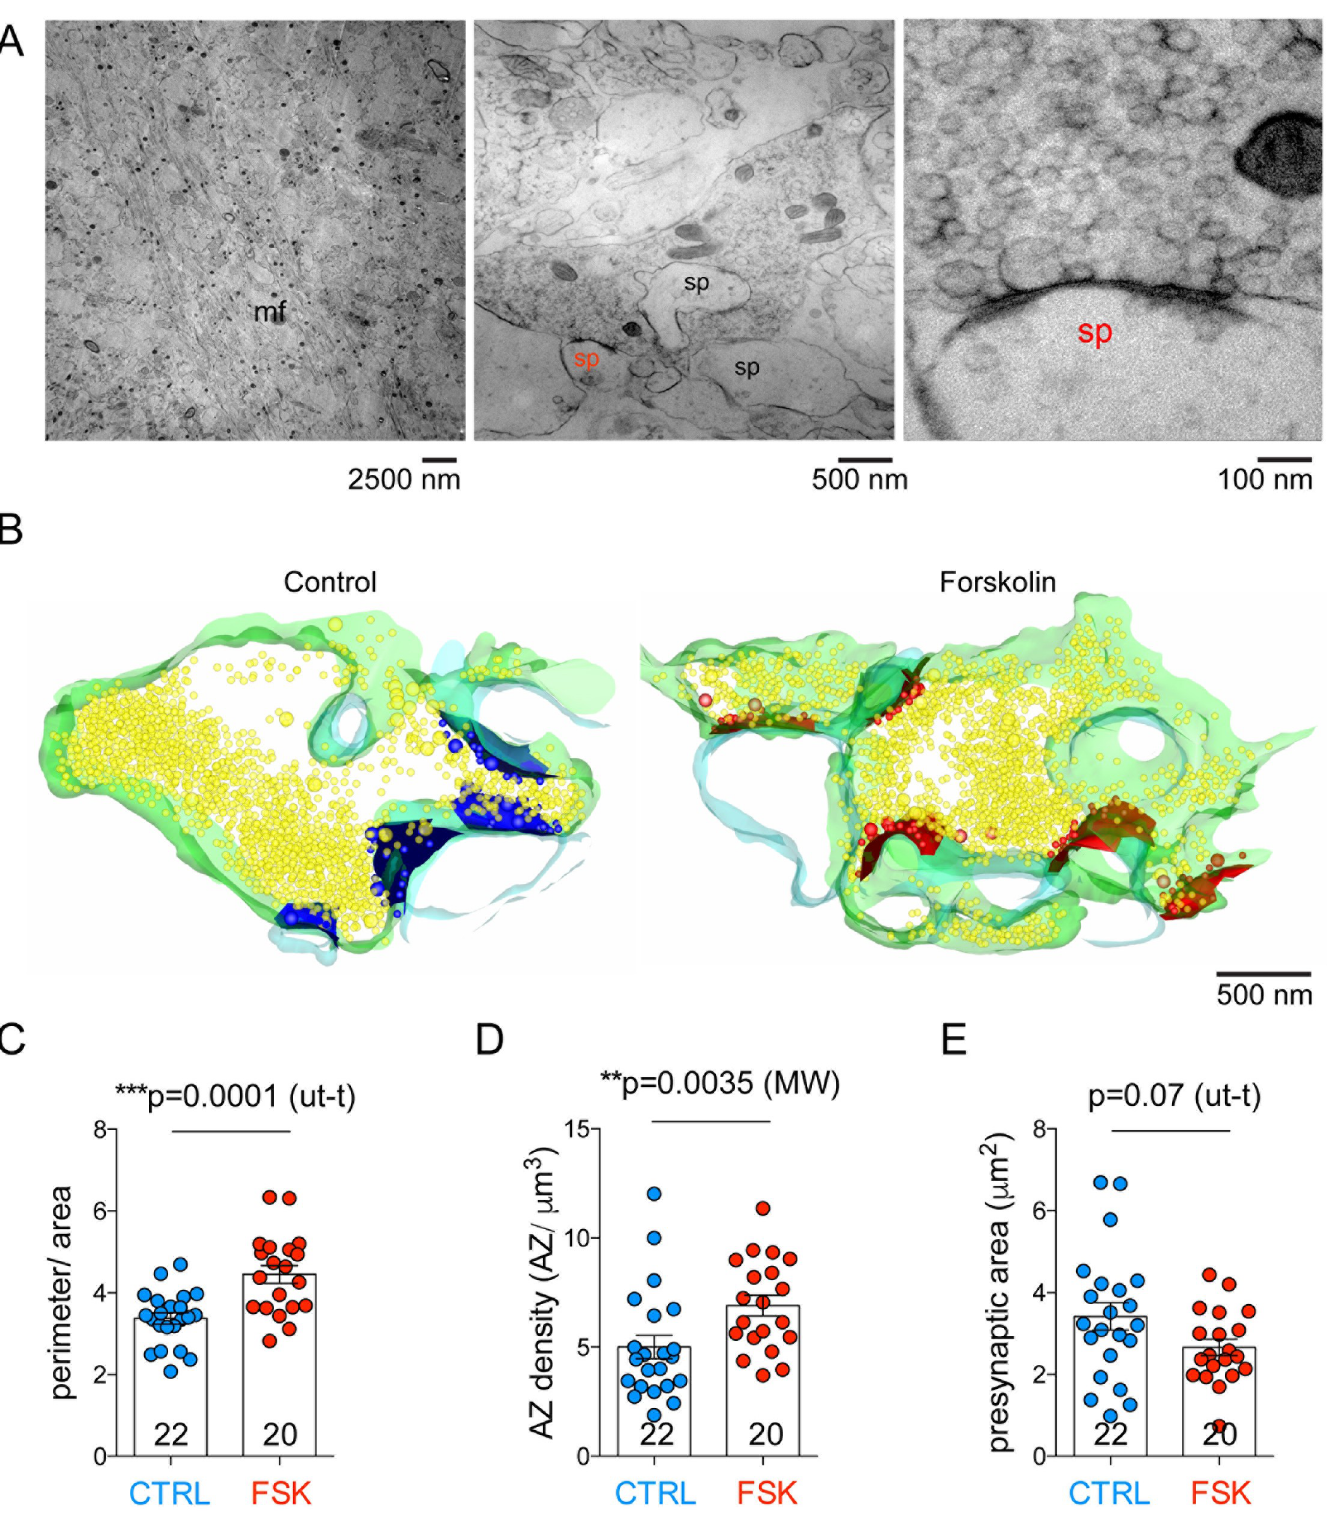
Fig 4. Three-dimensional EM analysis reveals an increase in presynaptic complexity and AZ density in forskolin-treated cryo-fixed acute slices. (A) EM image of the stratum lucidum of the hippocampal CA3 region. Mossy fiber axon bundles (mf) are visible in the left panel. In the central panel, large presynaptic terminals contacting multiple spine heads (sp) are visible. The right panel shows a high-magnification image of a single AZ; this is a magnification of the spine marked in red (sp)